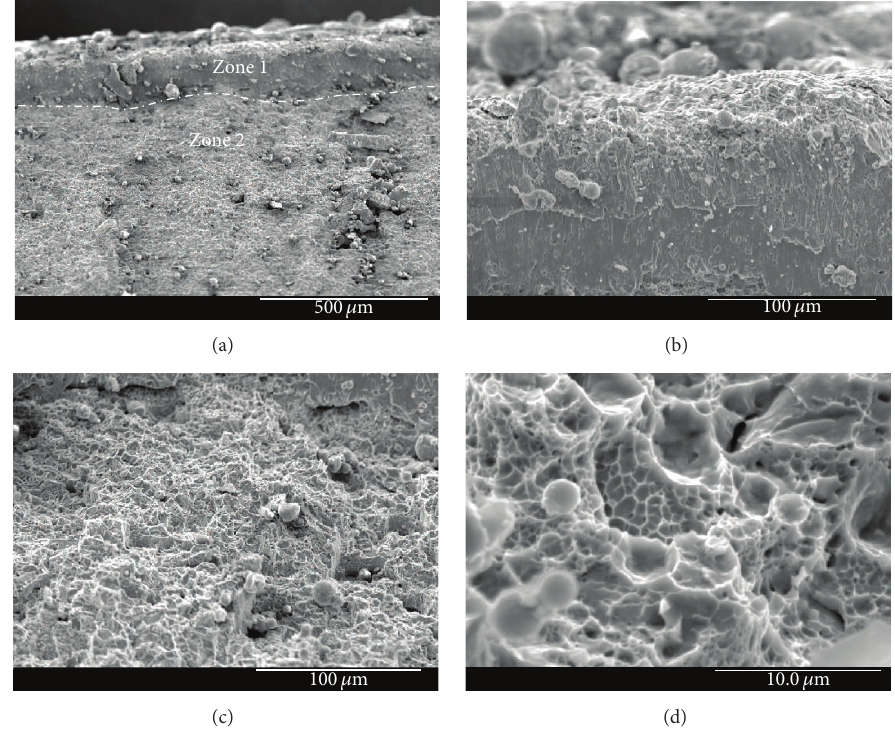
Figure 4: Fracture morphology of (a) the overall feature in (b) Zone 1 and in (c) Zone 2 and (d) high magnification of Zone 2.